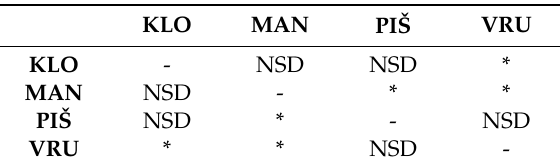
Table 5. Results of the t-test of the δ 15 N values of the muscle tissues (NSD = no statistical significance, * = statistical significance at a confidence level of p ≤ 0.05).